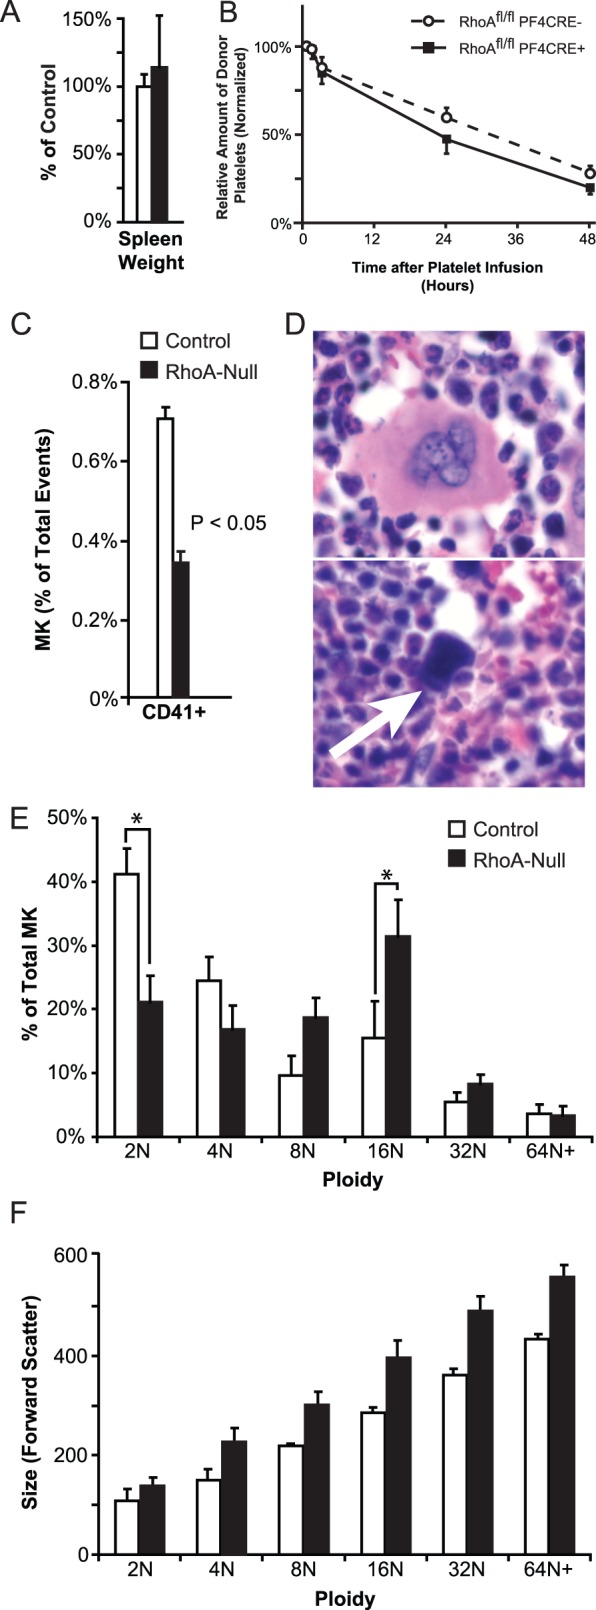
RhoA deletion disrupts megakaryocyte development.(A) The differences in spleen weights were not statistically significant. (B) When adult RhoA-null platelets were infused into mαIIb−/−/hαIIb+/+ mice, the time course of platelet survival was similar to that of their controls. Differences were not statistically significant. Shown is the mean ±SE (N = 3). Values were normalized to platelet levels at the initial draw for each experimental group (30 minutes after infusion). (C) Flow cytometry revealed that the megakaryocyte population, as a percentage of the total bone marrow cells, was diminished in the RhoAfl/fl PF4CRE+mice. Megakaryocytes were discriminated by size and by the use of a FITC-labeled anti-CD41 antibody. Mean ± SE is shown. N = 3. (D) On the top is a representative image of a normal megakaryocyte, and on the bottom is a megakaryocyte (arrow) undergoing apoptosis that is exhibiting dark, pyknotic nuclei and scant cytoplasm. In the bone marrow and in the spleen of RhoAfl/fl PF4CRE+ mice, megakaryocytes are more likely to exhibit this phenotype. Magnification is 40×. (E) The RhoA-null megakaryocyte population has a higher ploidy than normal. Ploidy was calculated by DNA staining with propidium iodide, and we measured staining intensity with flow cytometry. Mean ± SE is shown; * indicates P<0.05. N = 3. (F) Megakaryocyte size (forward scatter) was measured as a function of ploidy. The results show that RhoA-null megakaryocytes were larger than the control cells at all ploidy. Mean ± SE is shown; * indicates P<0.05; ** indicates P<0.01. N = 4.